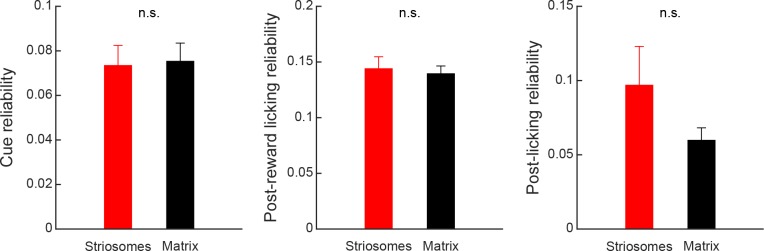
Response reliability of task-related responses of striosomal (red) and matrix (black) neurons.Reliability of responses during the cue (left), post-reward licking (middle), or post-licking (right) task epochs for striosomal and matrix neurons was quantified as the average correlation for all pairwise combinations of trials. Only neurons that were task-modulated during these epochs were included in the analysis.